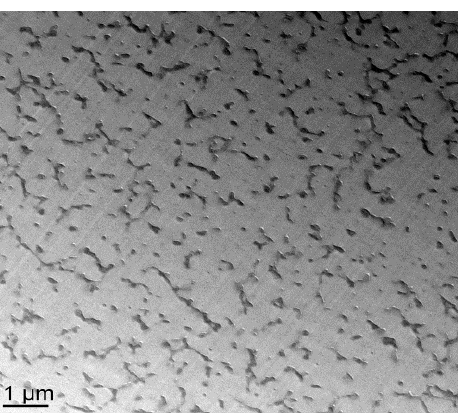
Figure 6. SEM observations on fracture surfaces (after a chemical treatment) of the nf-PES-based blends as a function of the curing temperature: 90 °C ( a ); 130 °C ( b ); 150 °C ( c ).